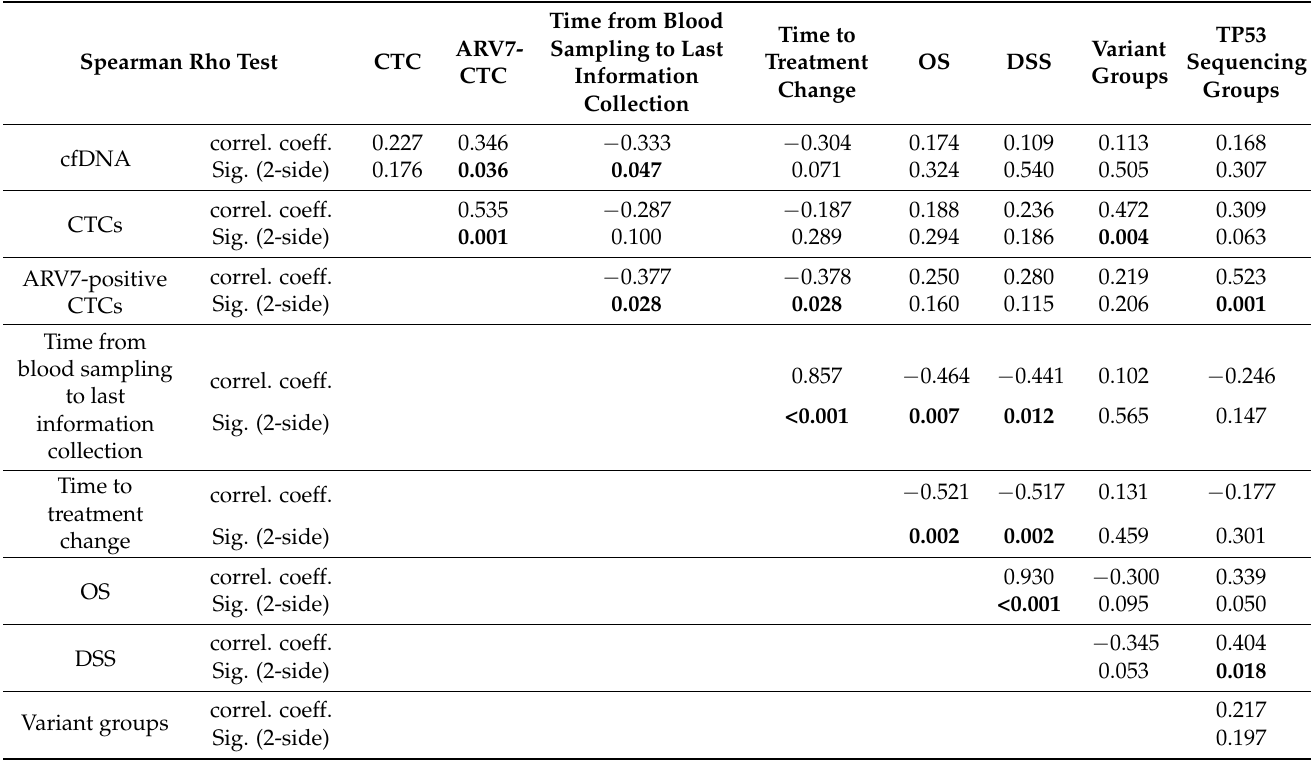
TP53 Variant Sequencing Groups Groups